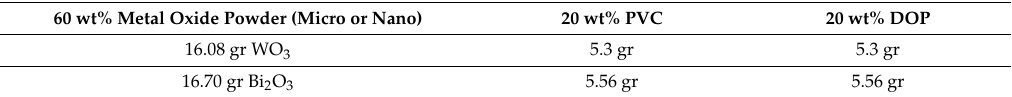
Table 1. Calculated composite component mass.